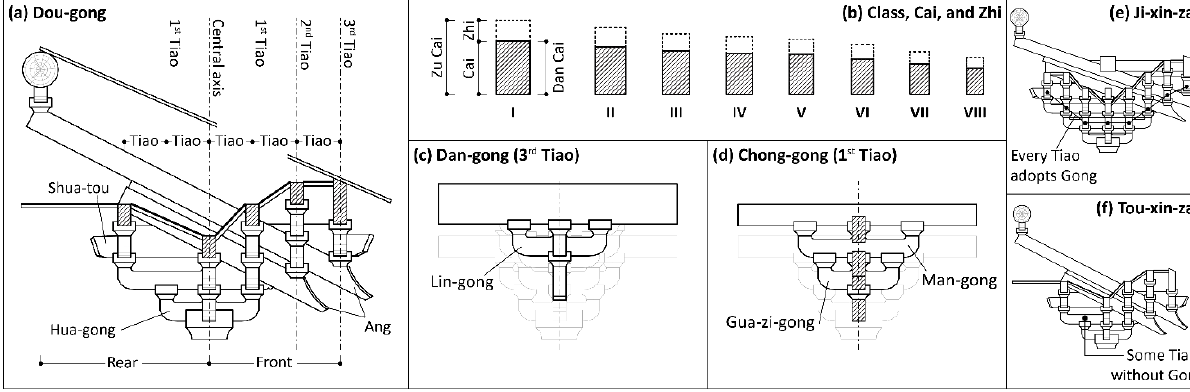
Figure 2. Description of Dou-gongs used in ancient China: ( a ) a typical section of Dou-gong, name of terms and components; ( b ) eight classes of section, definition of Dan and Zu Cai; ( c ) Dan-gong: single Gong supports the beam above; ( d ) Chong-gong: two Gongs are stacked to support the beam above; ( e ) Ji-xin-zao: every Tiao of the Dou-gong adopts Gongs; ( f ) Tou-xin-zao: some Tiaos of the Dou-gong do not use Gongs.